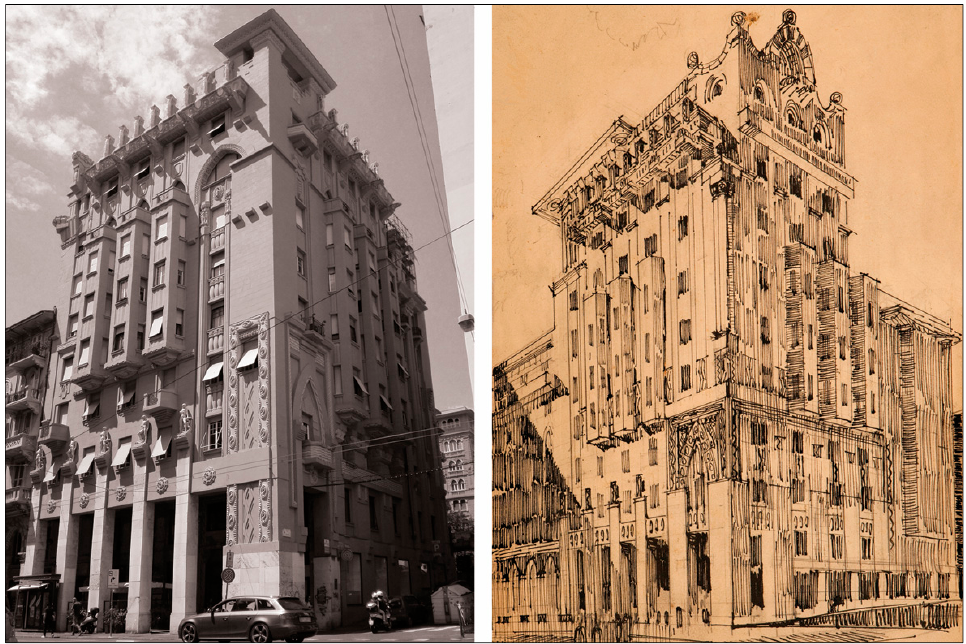
Figure 1. Photo of the facade of “Skyscraper” compared with a drawing by Arch. Bibbiani (A.R.B.).